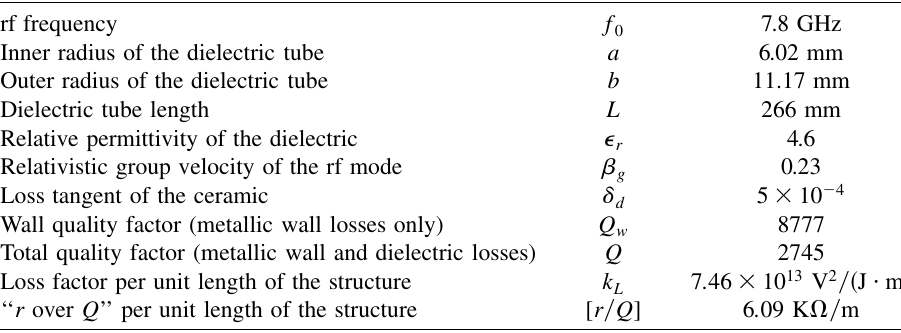
TABLE I. Design parameters of the dielectric-loaded